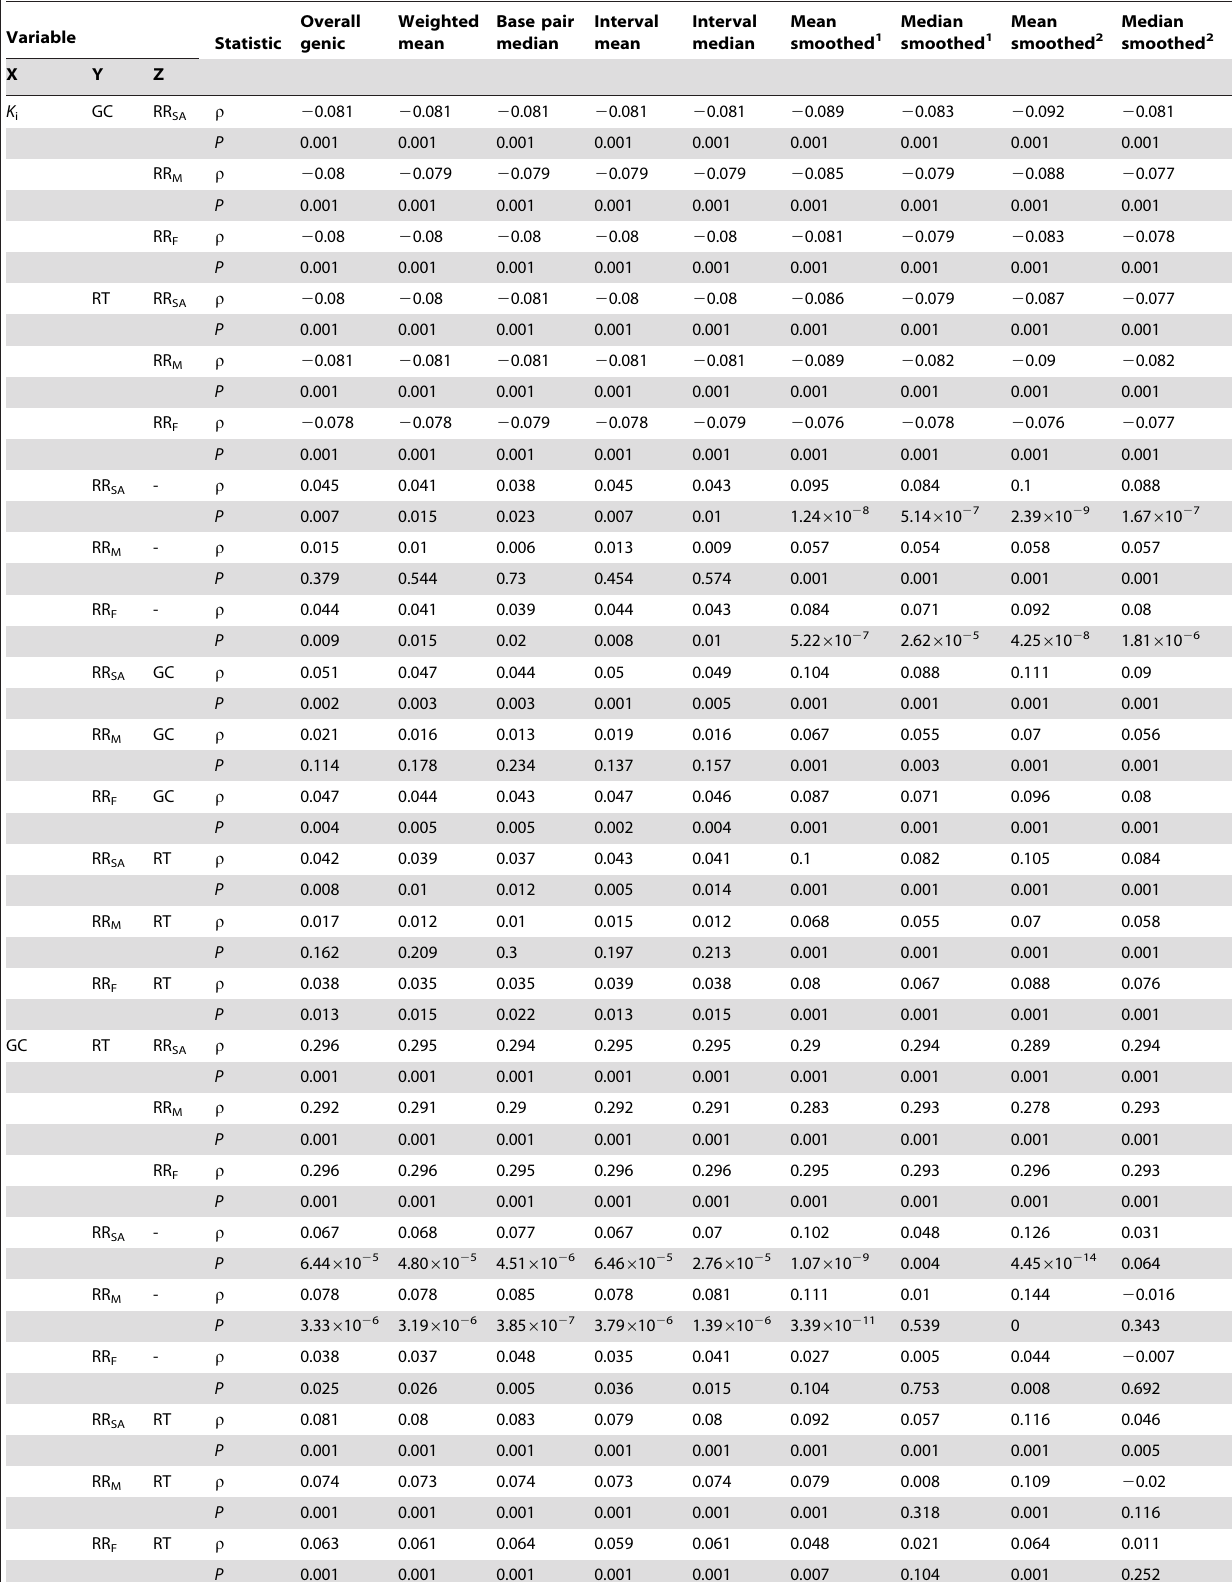
Table 1. Spearman’s correlations using alternative recombination rate datasets.